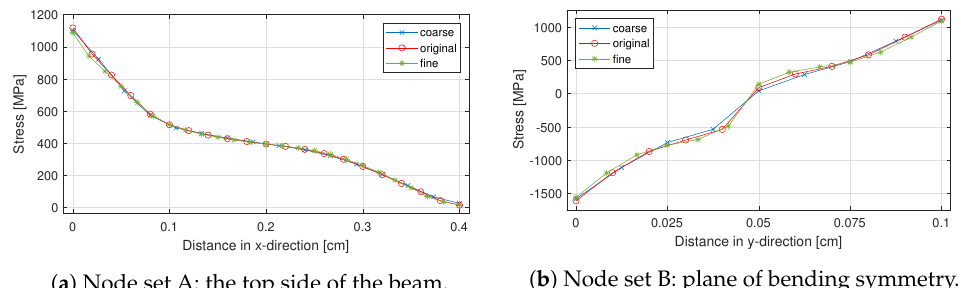
Figure A1. Variation of the normal stress component parallel with the x axis with positions of nodes for three different mesh densities (Example